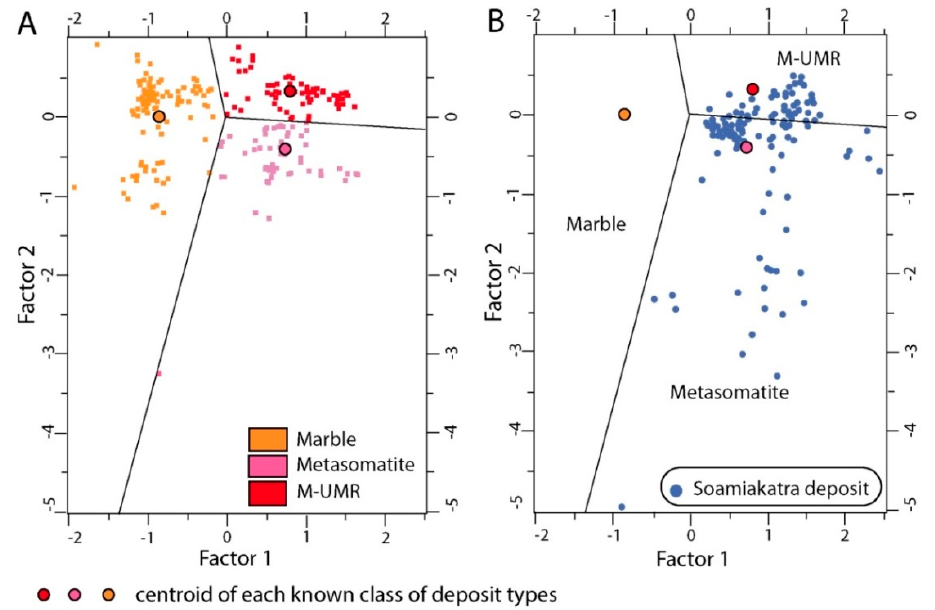
Figure 18. Discriminant factors analysis using oxide concentrations in ruby; modified from [72]. ( A ) Diagram used to distinguish between the different types of ruby deposit (marble, metamorphosed mafic and ultramafic rocks (M-UMR), and metasomatite) with the centroids of the known deposit classes and ( B ) prediction of the geologic origin of rubies from the Soamiakatra deposit in the Antanarivo province of Madagascar.